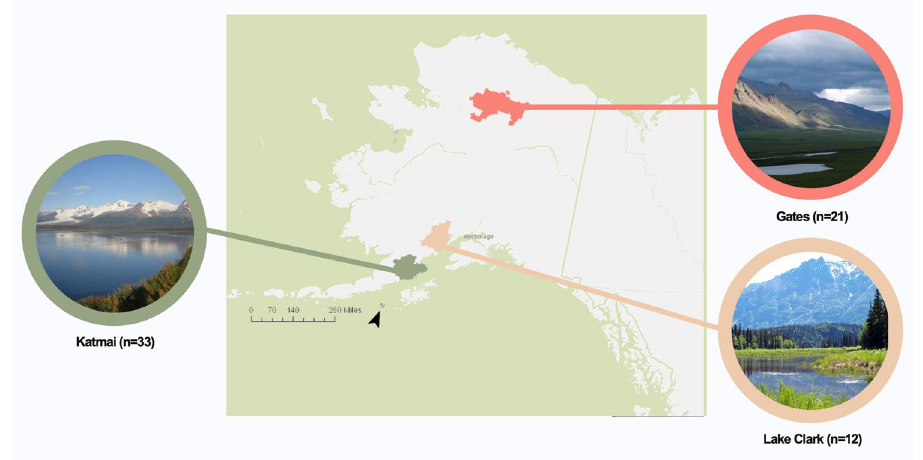
Figure 3. Map of study areas: Katmai National Park and Preserve (Katmai; n = 33), Lake Clark National Park and Preserve (Lake Clark; n = 12), and Gates of the Arctic National Park and Preserve (Gates; n = 21). Photos of parks by National Park Service. Map created using R (version 4.0.2.; R Core Team 2020), RStudio (version 1.3.1056; RStudio Team 2020), sf (R, version .0-7), tmap (R, version 3.3-3), and spData (R, version 2.0.1). Park boundary shapefile from National Park Service (https:// irma. nps. gov/ DataS